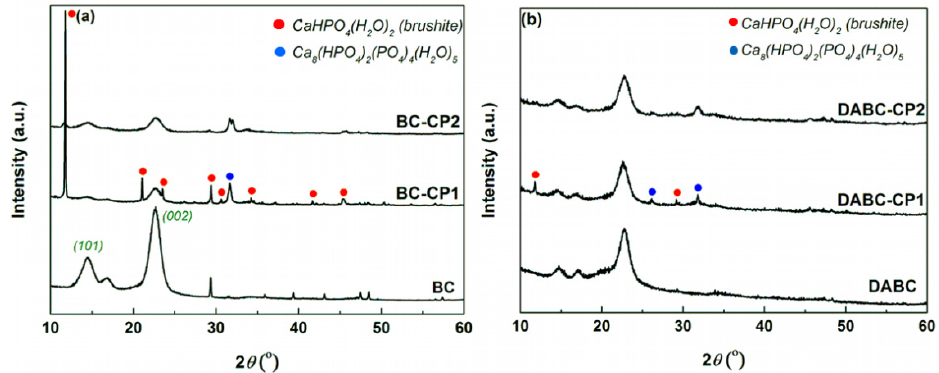
Figure 6. X-ray diffractograms of ( a ) BC, BC-CP1, and BC-CP2 and ( b ) DABC, DABC-CP1, Figure 6 . X ‐ ray diffractograms of ( a ) BC, BC ‐ CP1, and BC ‐ CP2 and ( b ) DABC, DABC ‐ CP1, and DABC ‐ CP2. and